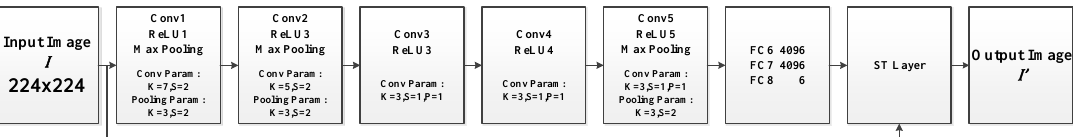
Figure 3. The FOD classification framework.